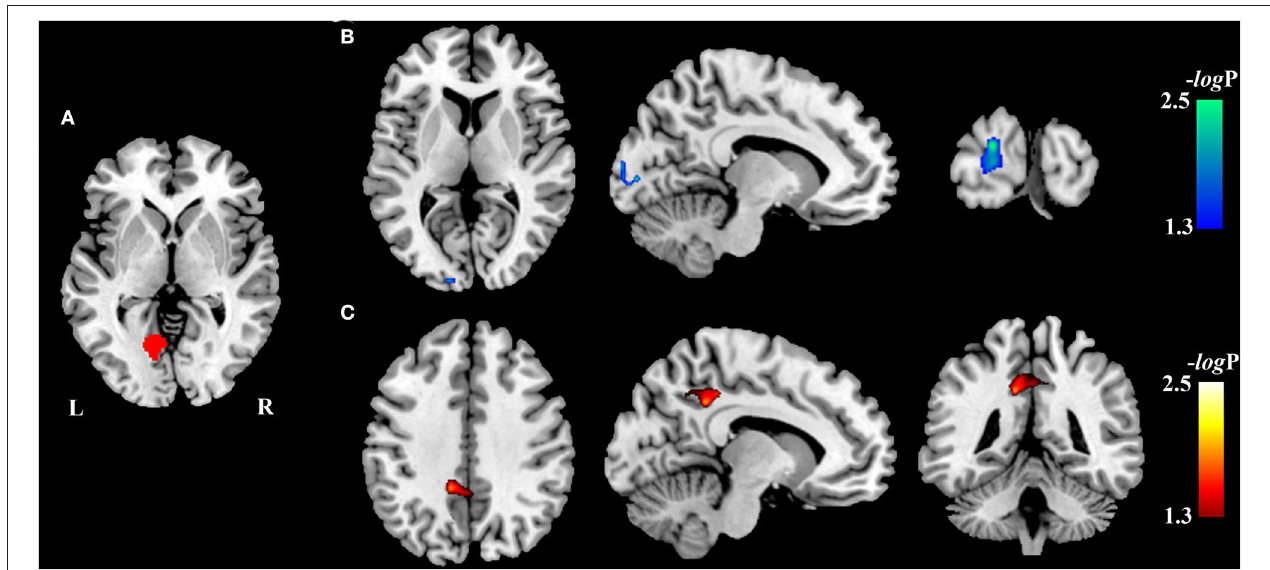
FIGURE 2 | Inter-group differences in resting-state functional connectivity. The difference in FC between the chronic LHON and HC was test using a voxel-wise non-parametric permutation test corrected for age and gender ( p < 0.05, TFCE-FWE corrected). Color bar represents the -log10(p) value. (A) Seeds (left CG) used to calculate the FC, (B) brain region (left SOG, cool color) having lower FC with the left CG in the chronic LHON, and (C) brain region (left PCC, warm color) having higher FC with the left CG. CG, calcarine gyrus; FC, functional connectivity; FWE, family-wise error; HC, healthy controls; LHON, Leber’s hereditary optic neuropathy; PCC, posterior cingulate cortex; SOG, superior occipital gyrus; TFCE, threshold-free cluster